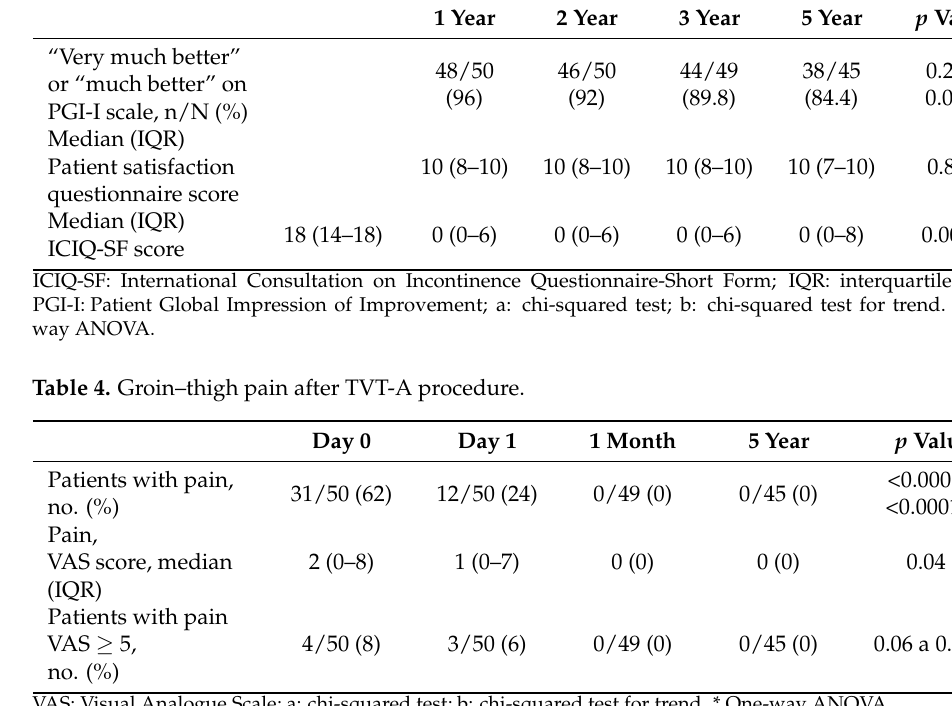
Table 3. Subjective outcome scores over time after TVT-A procedure.